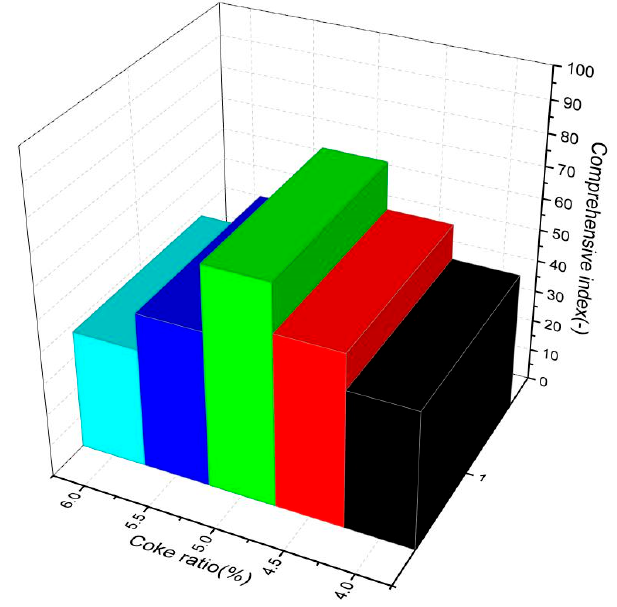
Figure 9. Effect of the coke ratio on the comprehensive index of HCVTS.